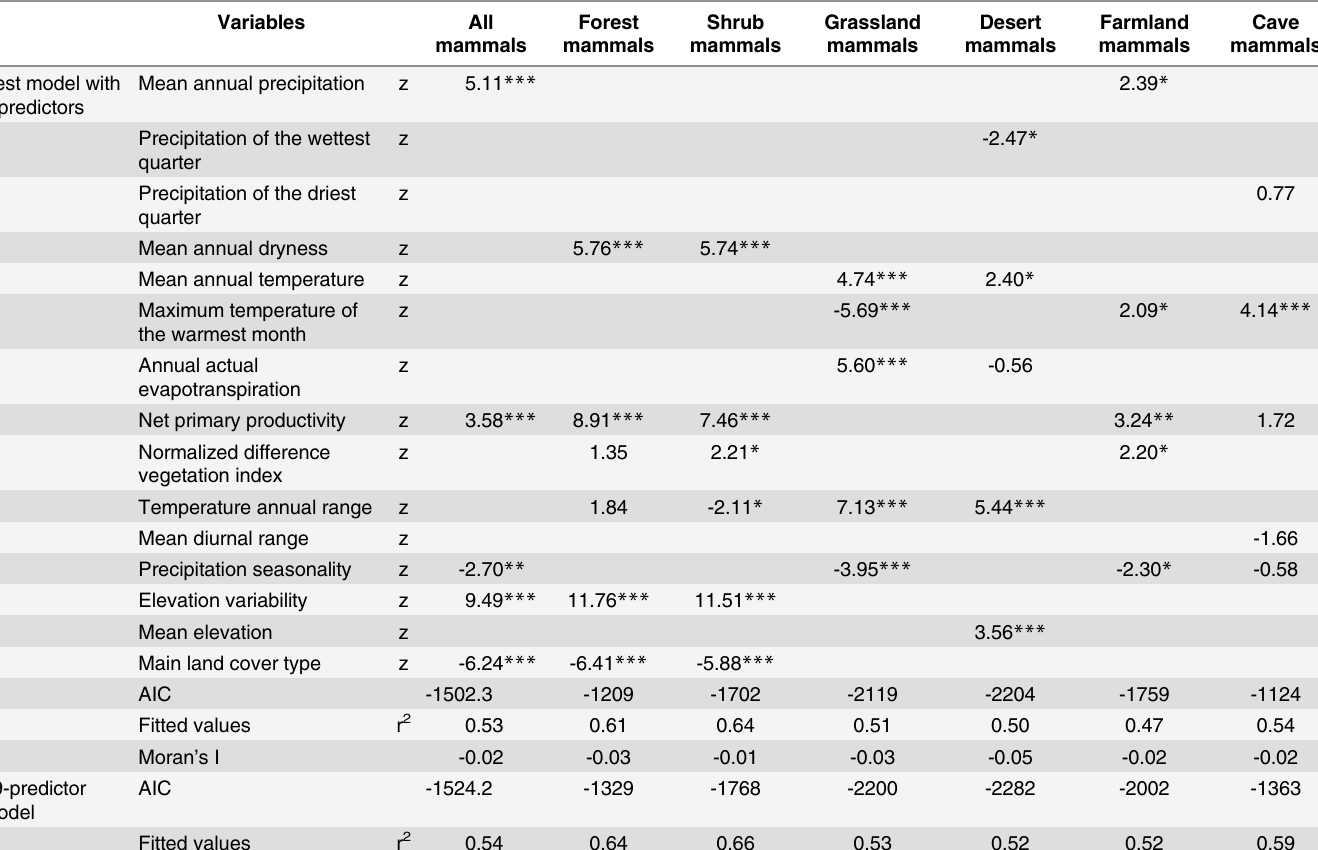
Table 2. SLM multivariate models for the residuals of species richness of all mammals and its habitat